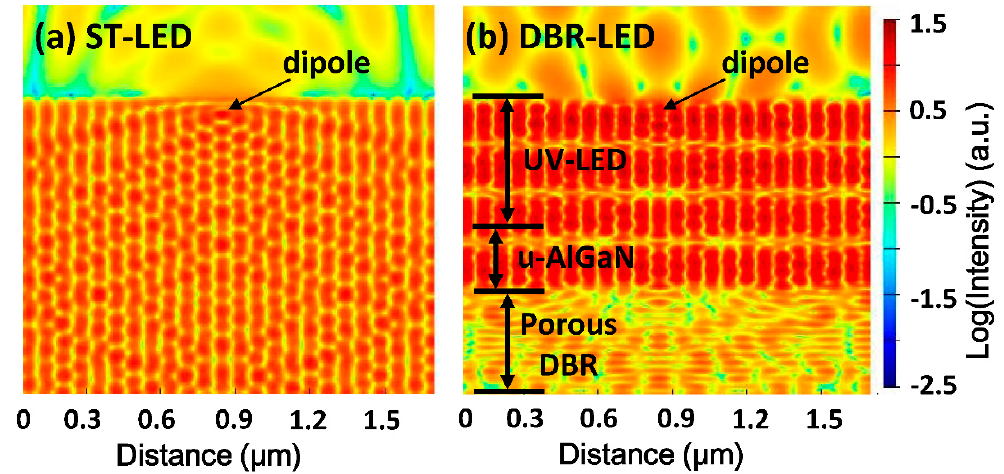
Figure 7. Simulated electric field distribution of ( a ) ST-LED and ( b ) DBR-LED. The light source was a TE polarized dipole, and the electric field intensity is presented in log scale.